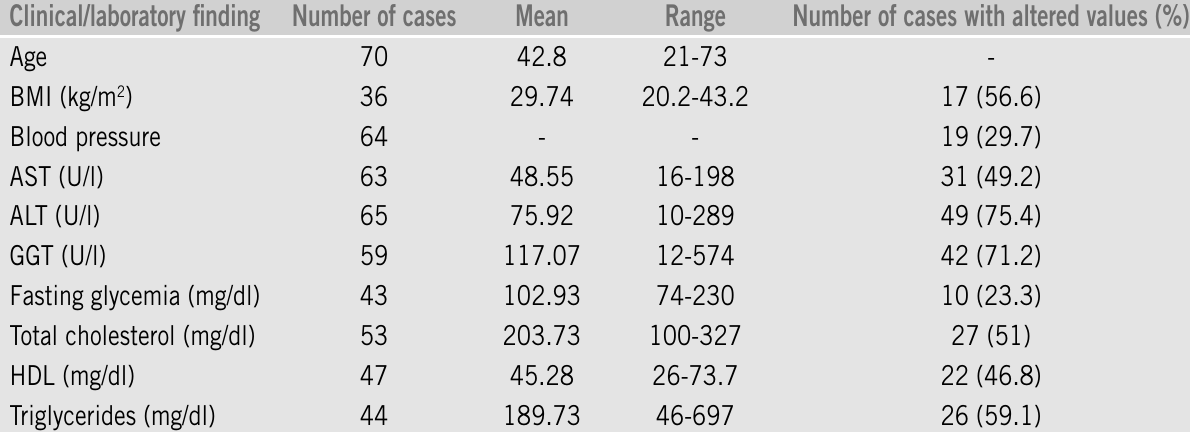
Available clinical and laboratory findings of the 70 cases studied Clinical/laboratory